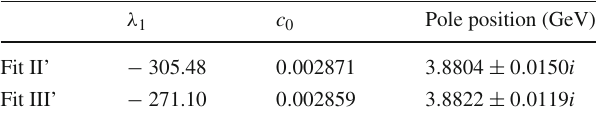
Table 2 The parameters which decide the pole position of Fit II’ and Fit